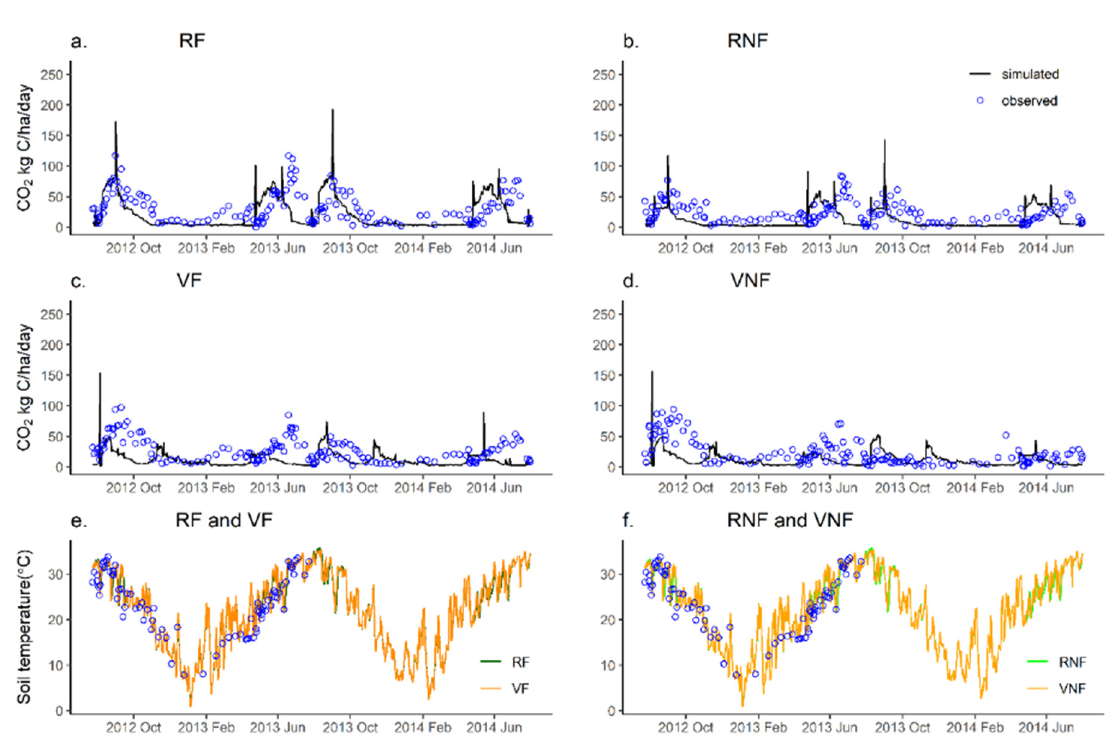
Figure 3. Observed and simulated ( a – d ) daily CO 2 emission and ( e , f ) soil temperature (5 cm) from 2012 to 2014 under different cropping systems and fertilizations. RF: rice with fertilization; RNF: rice without fertilization; VF: vegetable with fertilization and VNF: vegetable without fertilization.